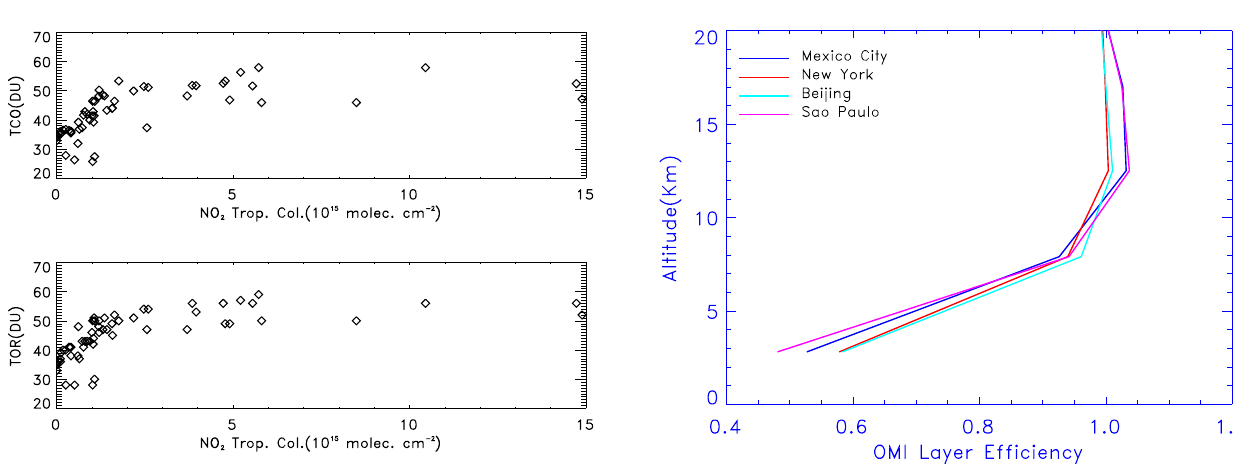
Fig. 5. Layer efficiency profiles near New York (July 2005), Beijing (August 2005), Sao Paulo (October 2005) and Mexico City outflow plume (February 2005) from the OMI level 2 data for reflectivity less than 0.3.